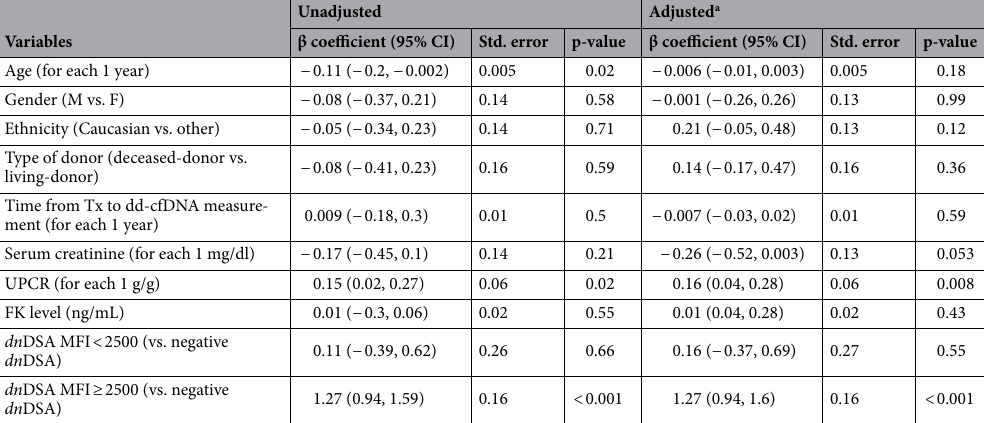
Table 2. Linear regression to evaluate determinants of absolute dd-cfDNA values. dd-cfDNA, donor-derived cell-free DNA; dn DSA, de novo donor-specific antibody; MFI, mean fluorescence intensity; Tx, transplant; UPCR, urine protein:creatinine ratio; M, male; F, female. a After multivariate adjustment for age, gender, race, type of transplant, serum creatinine, UPCR, FK level, time to dd-cfDNA determination and dnDSA MFI.